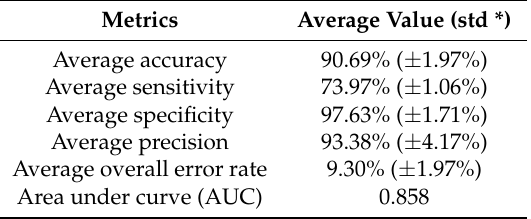
Table 2. Values of disease classification metrics by proposed method.